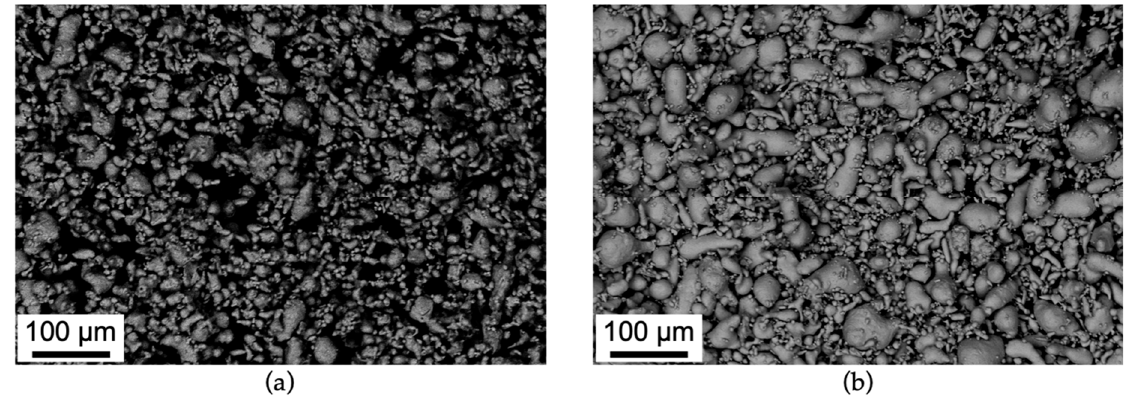
Figure 1. SEM micrographs of Al ( a ) and Sn ( b ) powders.